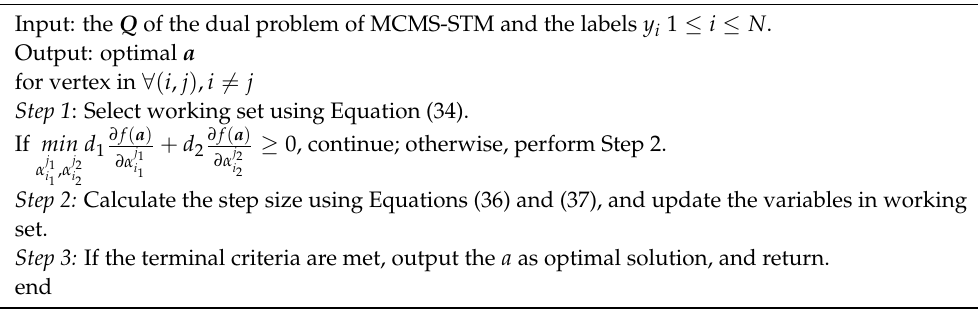
Algorithm 1. Decomposition algorithm of solving the dual problem of OVO version of the